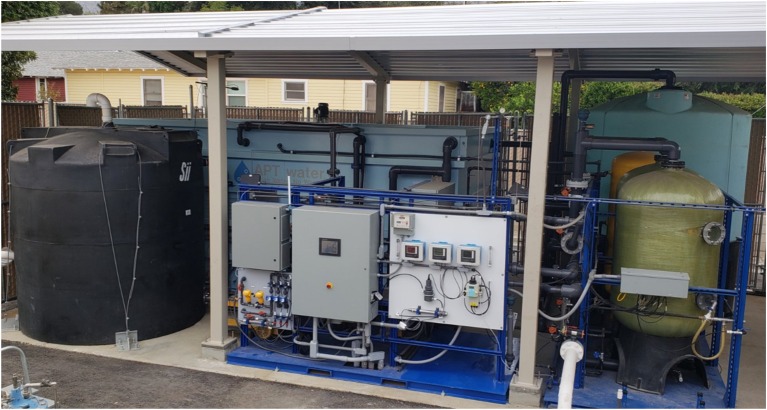
ARoNite™ System in La Crescenta, California.